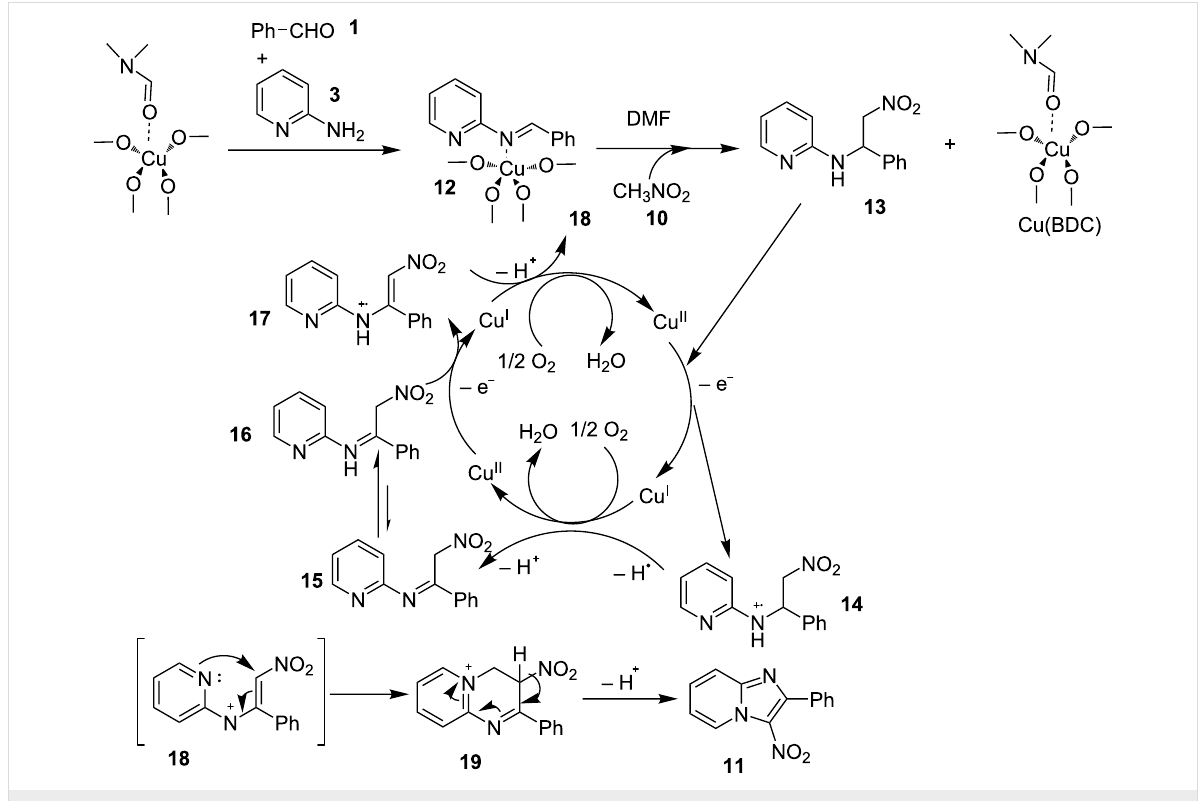
Scheme 6: Mechanism for copper-MOF-driven synthesis.